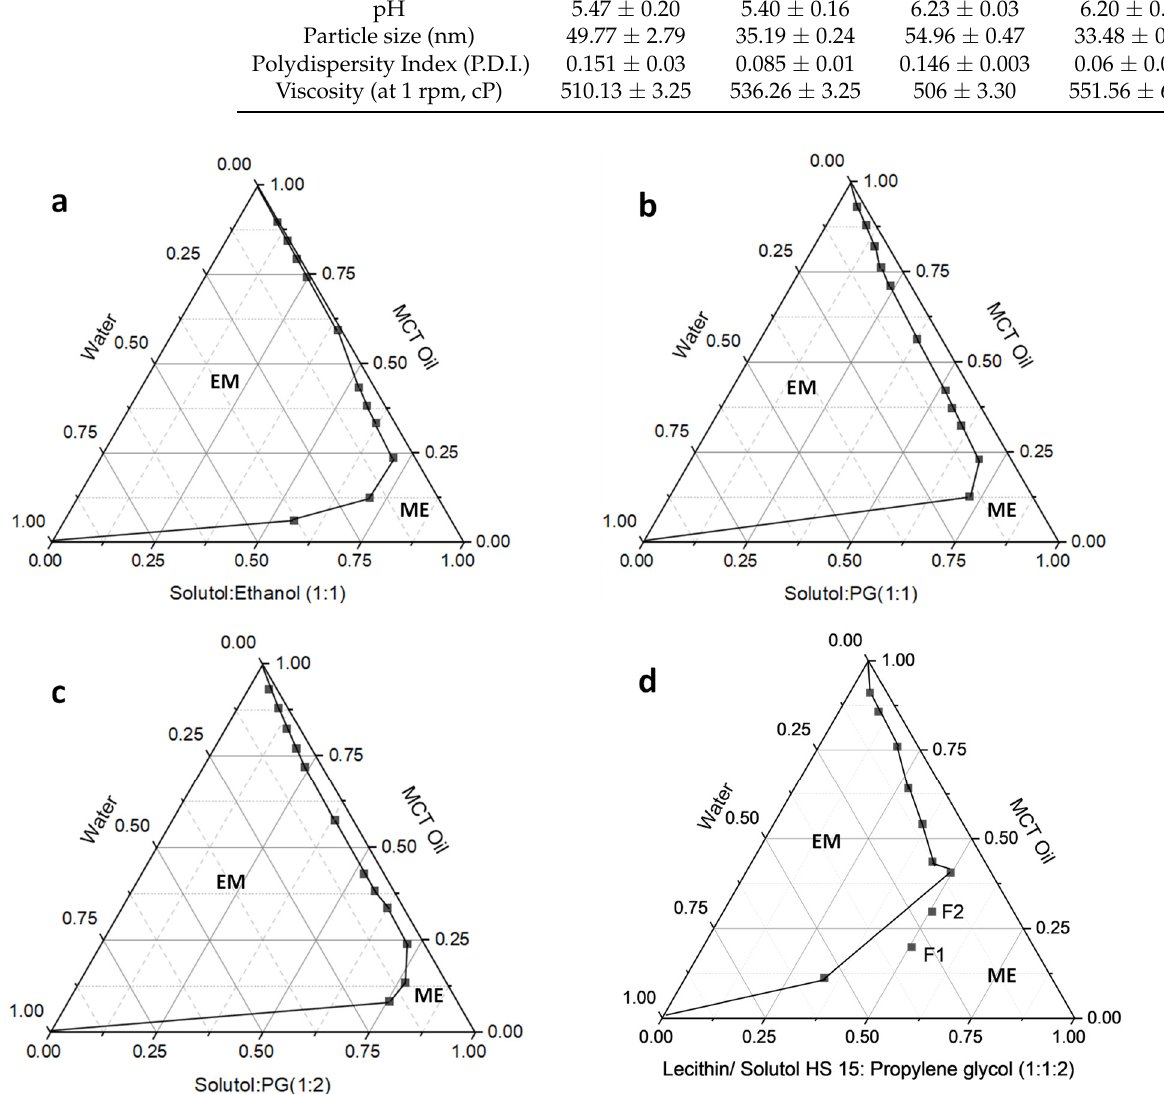
Figure 1. Pseudo-ternary phase diagrams of MCT Oil, Lecithin, Solutol ® HS 15, Propylene glycol, Water system; EM—emulsion, ME—microemulsion.